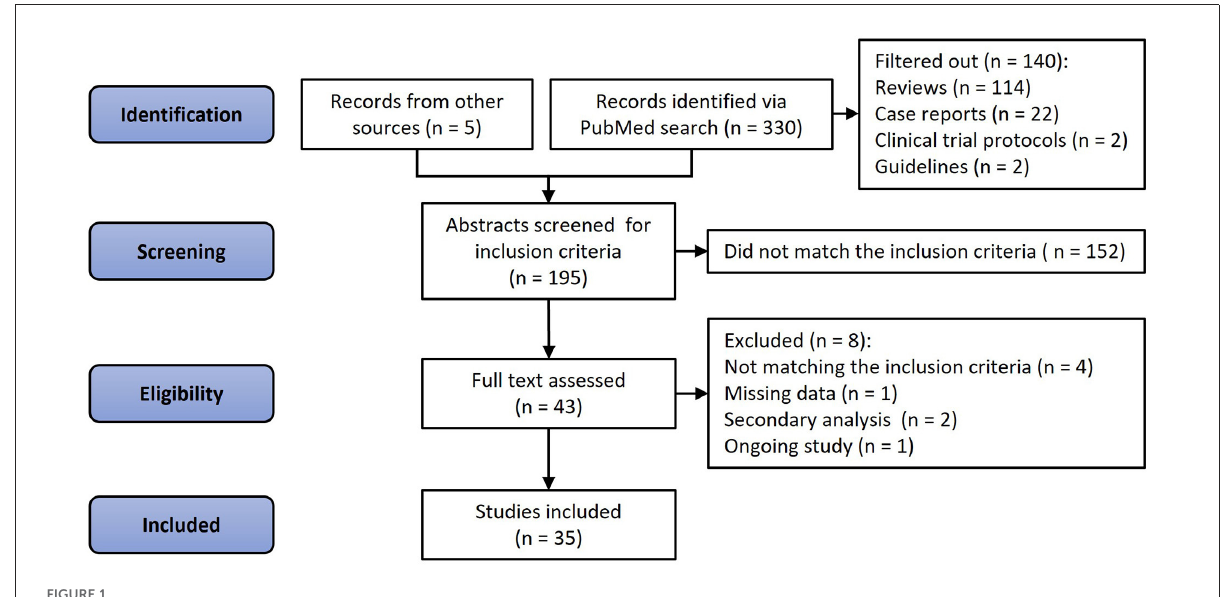
FIGURE1 Flow diagram of the literature